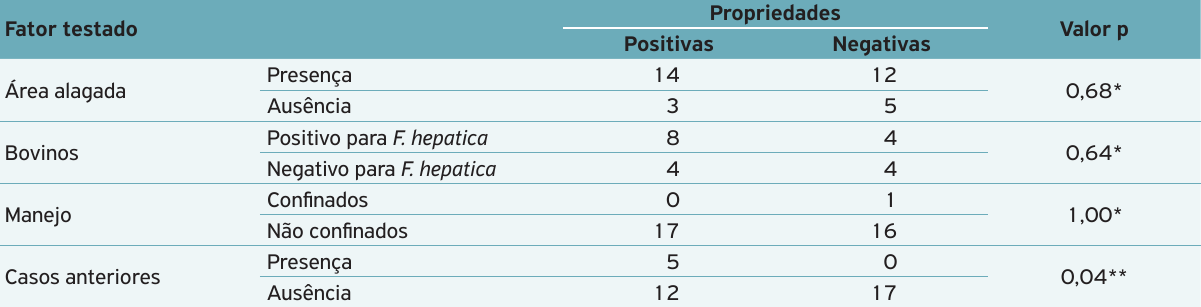
Tabela 2. Fatores associados ou não à ocorrência de Fasciola hepatica nas propriedades de municípios do sul do Espírito Santo.